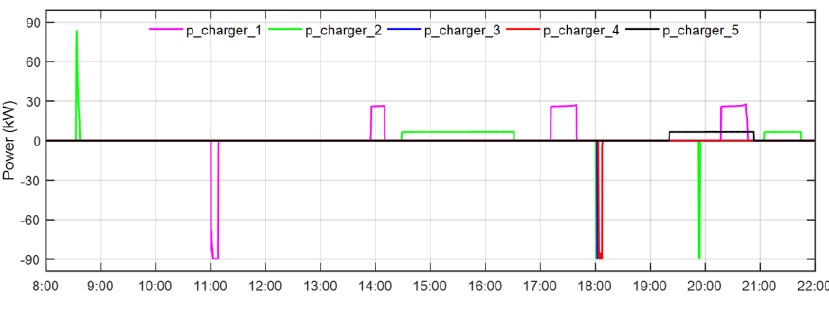
Figure 26. Power evolutions under SPVA.